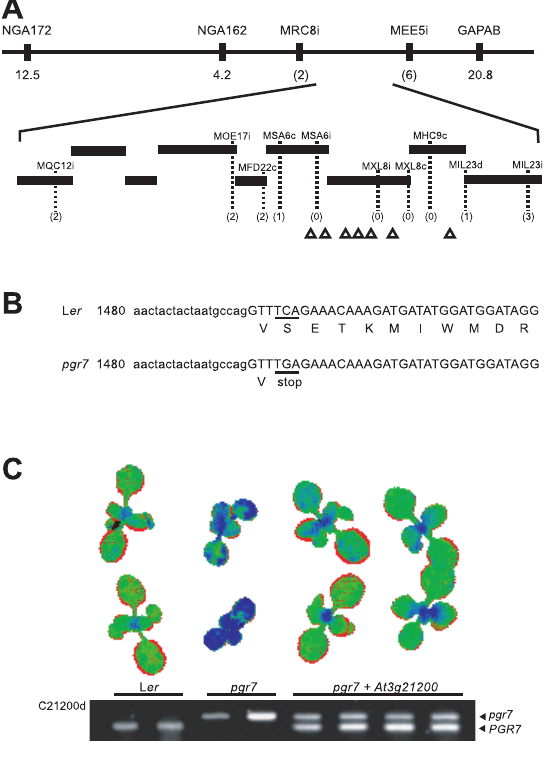
Figure 6. Cloning of the PGR7 gene and complementation of pgr7 . A) Positional cloning of PGR7 . The horizontal line at the top represents chromosome 3 with marker names above and numbers below showing distances (in cM) from the corresponding marker to the PGR7 gene. Numbers in parentheses are the number of recombinants detected. Bars represent BAC clones and the positions of genes encoding predicted chloroplast proteins are displayed with triangles. B) Partial DNA sequence of the At3g21200 gene in pgr7 and L er . The lower and upper cases indicate an intron and an exon region, respectively. The position of the transversion (C R G) in pgr7 and the resulting stop codon are underlined. C) Complementation of the low NPQ phenotype of pgr7 by the At3g21200 gene. In the pseudo-color image, wild-type level of NPQ is displayed as green and low NPQ as blue. The agarose gel image shows genotype results determined by the dCAPS marker C21200d.